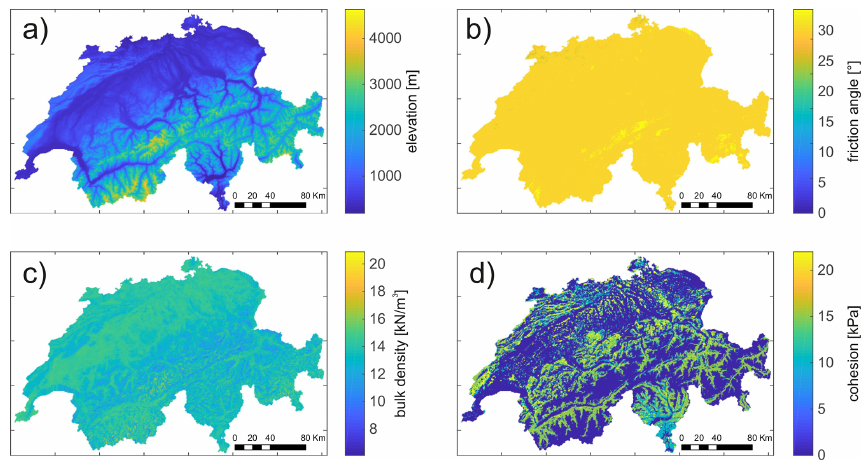
Figure 1. Maps of the distributed input used in the factor of safety calculations. (a) The 25m digital elevation model (Swisstopo), (b) friction angle obtained from the OpenLandMap USDA texture class and provided soil depth, (c) bulk density obtained from OpenLandMap, and (d) cohesion estimated for the land-cover map from OpenLandMap. The friction angle depends on the local soil depth; here soil depth is estimated with the linear diffusion